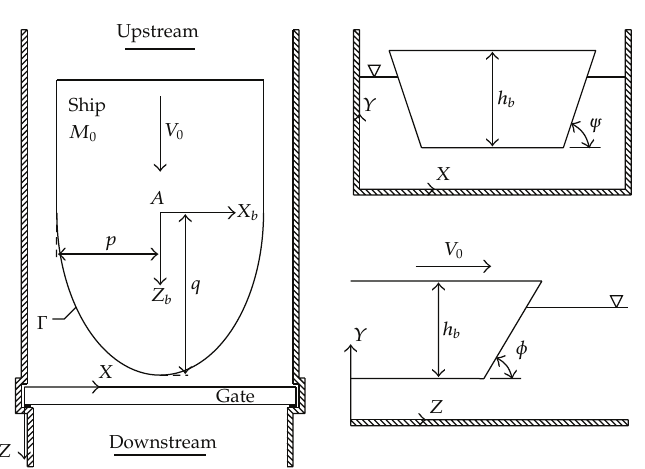
Figure 1: Plane and section views of the impact